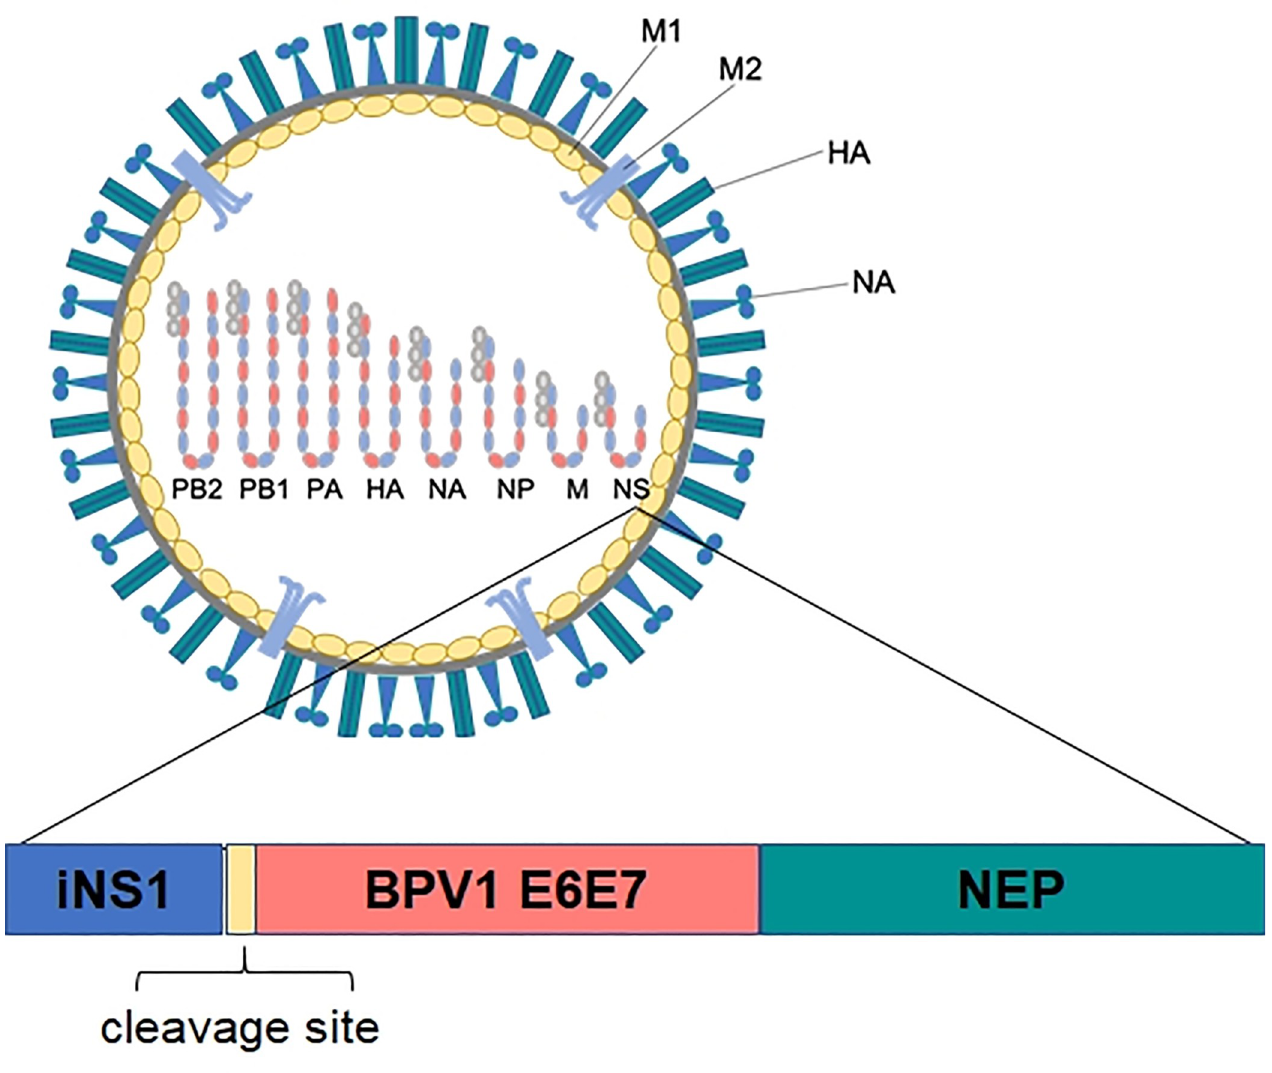
Fig 1. Schematics of iNSA or B/E6E7 equ . The Flu A or B NS1 gene was truncated to the first 106 C-terminal codons (iNS1) and shuffled BPV1 E6 and E7 sequences were inserted into the NS1 ORF.